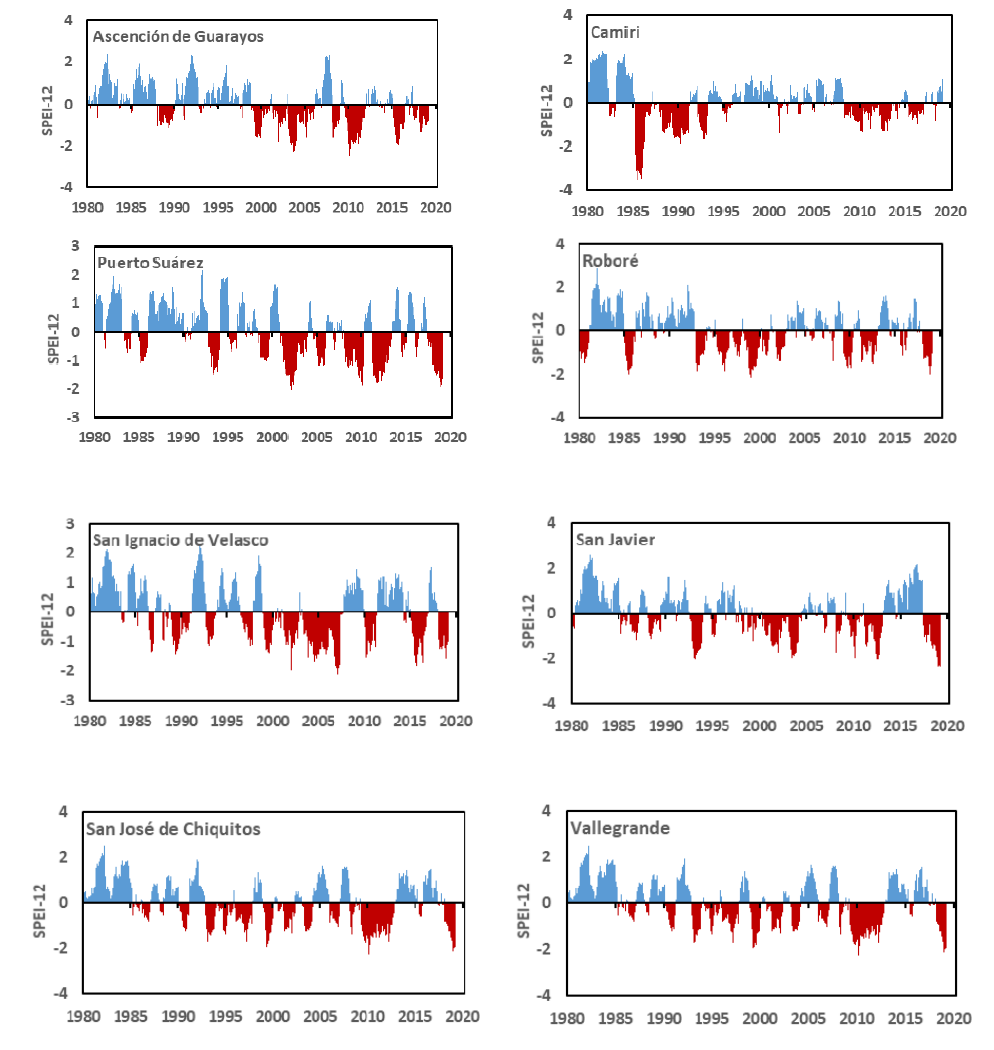
Figure 5. SPEI-12 time series (1980–2019) in eight weather stations in the Department of Santa Cruz. Table 3. Spatial analyses of drought trends SPEI ‐ 12 (1980–2019) for weather stations in the Department of Santa Cruz, in relation to the Mann ‐ Kendall test (Z) and Sen’s estimator (Q). Station (Name)